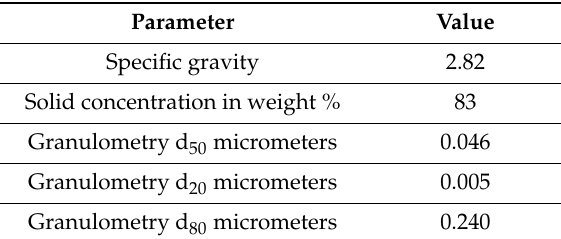
Table 2. Initial concentration of Mo, Cu and Pb in dry tailing ± confidence interval (IC).